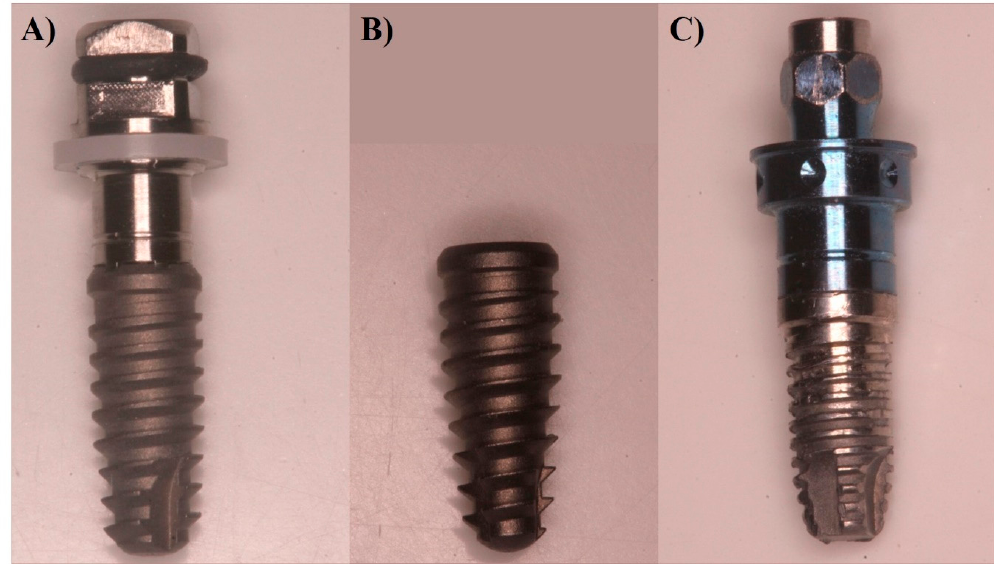
Figure 1. Summary of the study design of the present investigation.